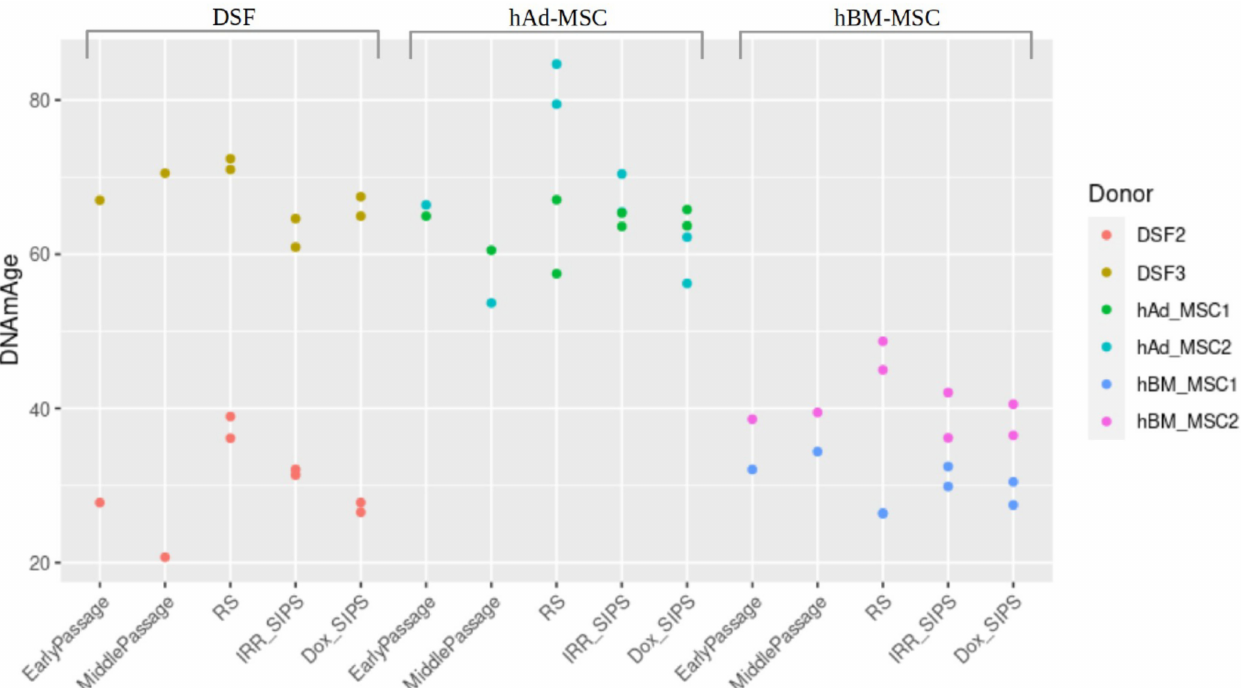
Figure 9. DNA methylation-based prediction of biological age using Horvath’s DNAmAge model in human DSF, hAd-MSC and hBM-MSC from different cell cultures: early-passage cells (EarlyPassage), cells after a middle number of passages (MiddlePassage), cells in replicative senescence (RS), cells in stress-induced premature senescence after exposure to ionizing irradiation (IRR_SIPS) and cells in stress-induced premature senescence after exposure to doxorubicin